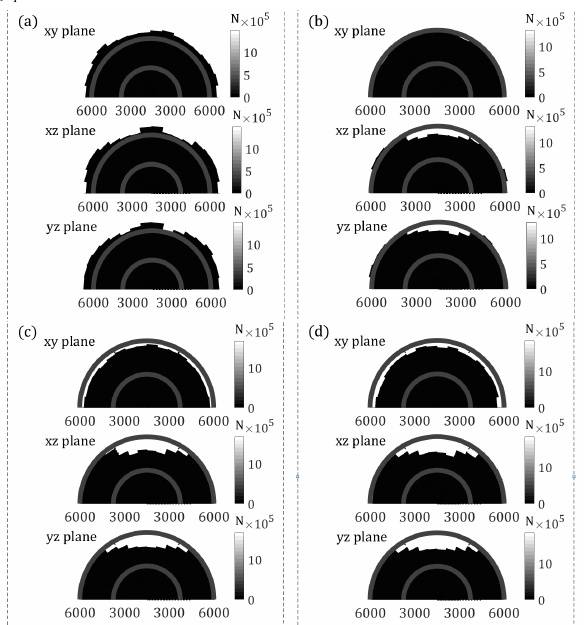
Figure 5. Contact distributions of the RM samples at (cid:15) a = 0 . 5%, with projections onto the xy, xz and yz planes, respectively: (a) µ p = 0 . 05; (b) µ p = 0 . 25; (c) µ p = 0 . 50; and (d) µ p = 0 . 75.